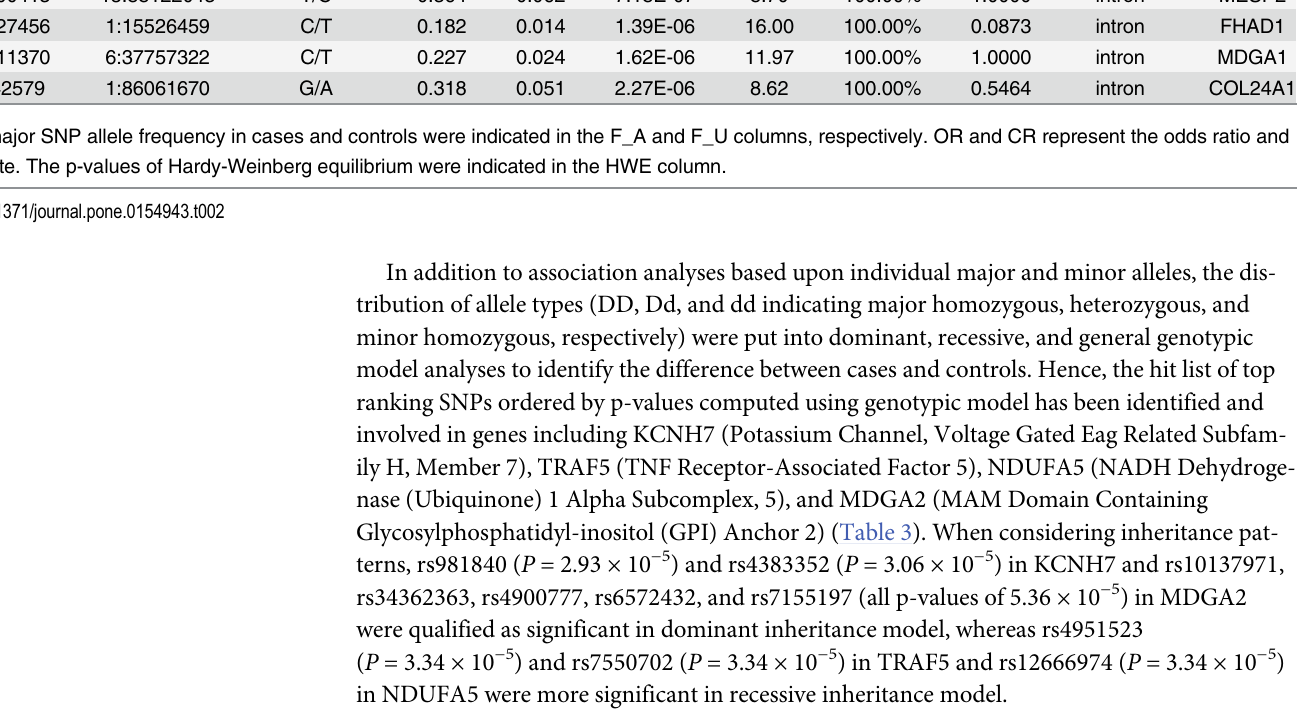
The major SNP allele frequency in cases and controls were indicated in the F_A and F_U columns, respectively. OR and CR represent the odds ratio and call rate. The p-values of Hardy-Weinberg equilibrium were indicated in the HWE column.